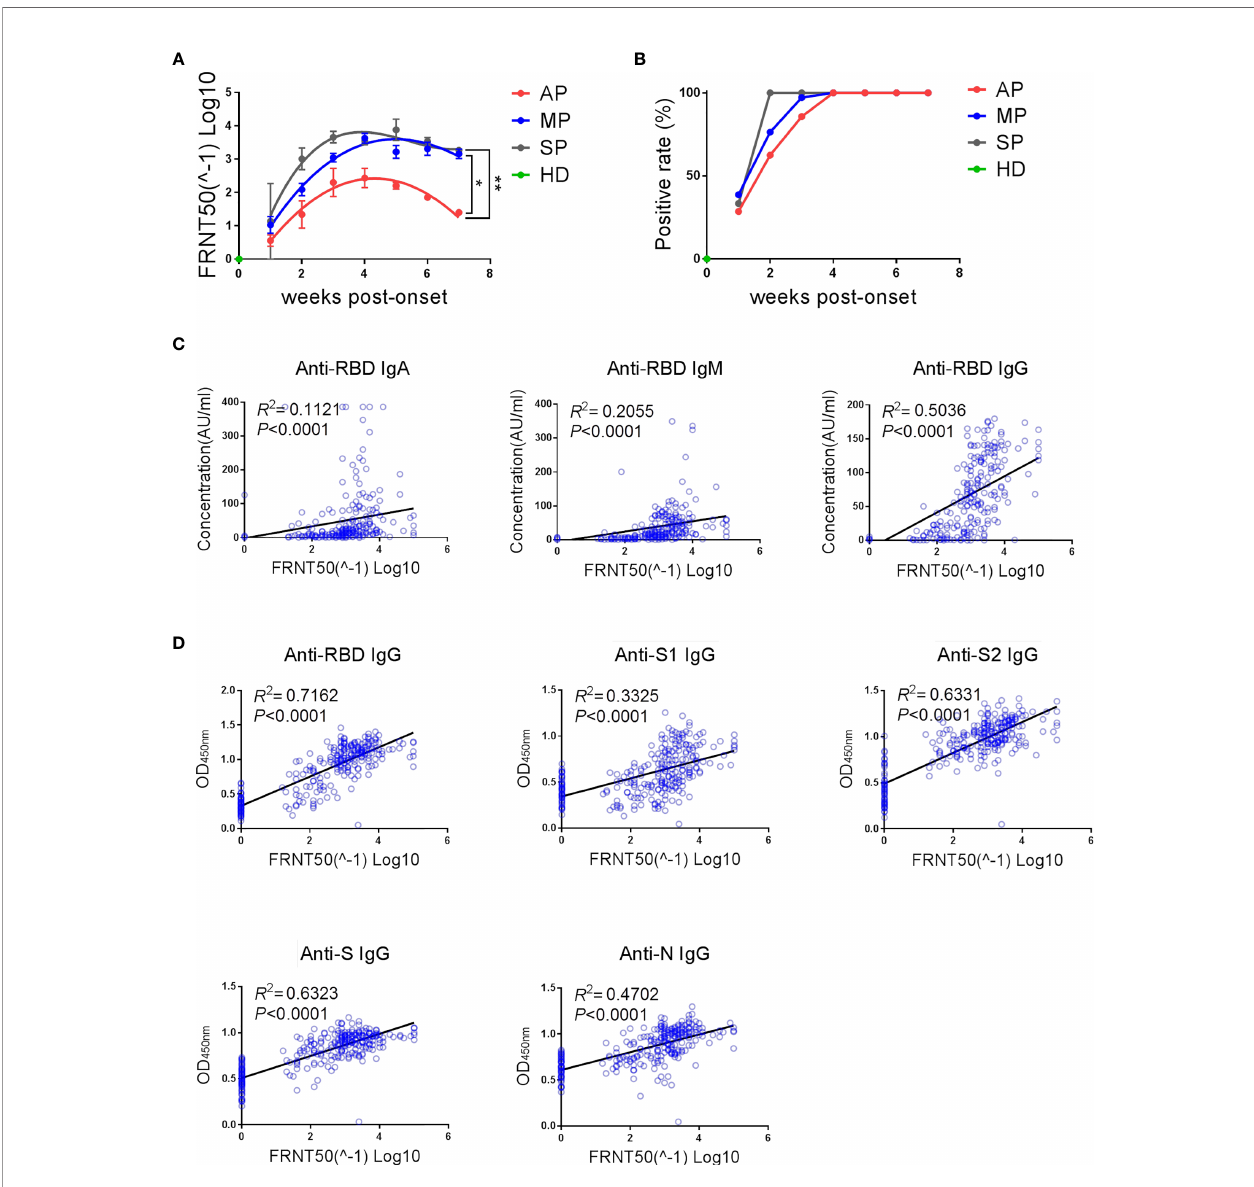
FIGURE 3 | The kinetics of neutralizing antibodies and its strong correlation with the magnitude of anti-SARS-CoV-2 binding antibodies. (A) Kinetics of neutralizing antibodies in different groups. The line is a trend line fi tted by Nonlinear Regression method. The neutralizing antibody titers were expressed as mean ± SEM. (B) Positive rates of neutralizing antibodies over time in different groups. (A, B) One-way ANOVA with Holm-Sidak ’ s multiple comparisons test was used. A p-value of ≤ 0.05 was considered statistically signi fi cant (*p-values of ≤ 0.05; **p-values of ≤ 0.01). (C) Correlation between neutralizing antibody titers and RBD-speci fi c IgA/ IgM/IgG concentrations detected by ECL assay was analyzed by linear regression. (D) Correlation between neutralizing antibody titers and multiple structural protein (RBD/S1/S2/S/N)-speci fi c IgG levels detected by ELISA assay was analyzed by linear